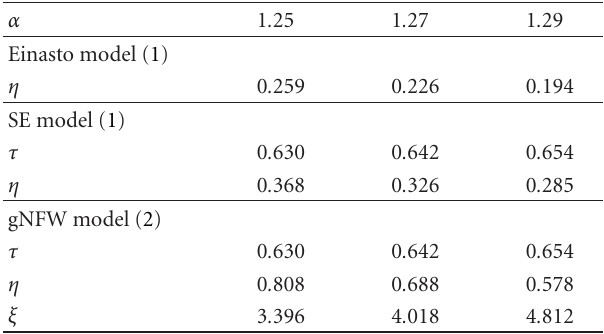
Table 2: Parameters of empirical models in the anisotropic